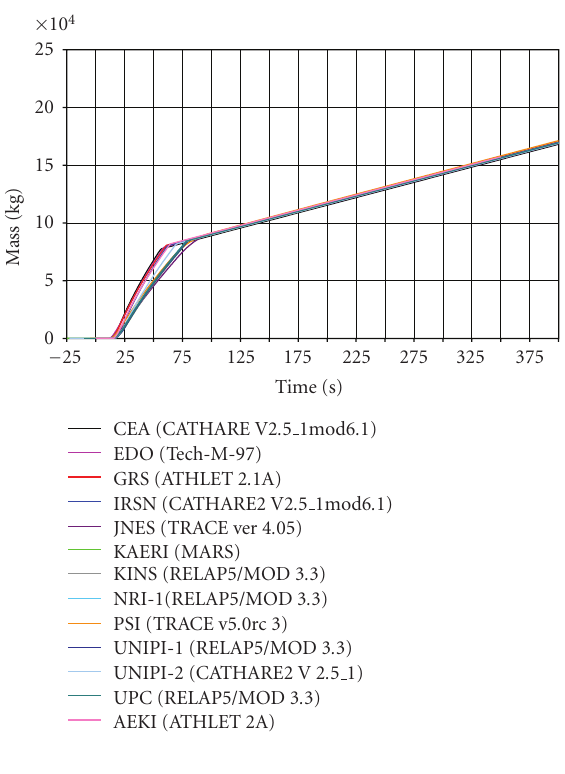
Figure 8: Time trends of ECCS integral mass flow.